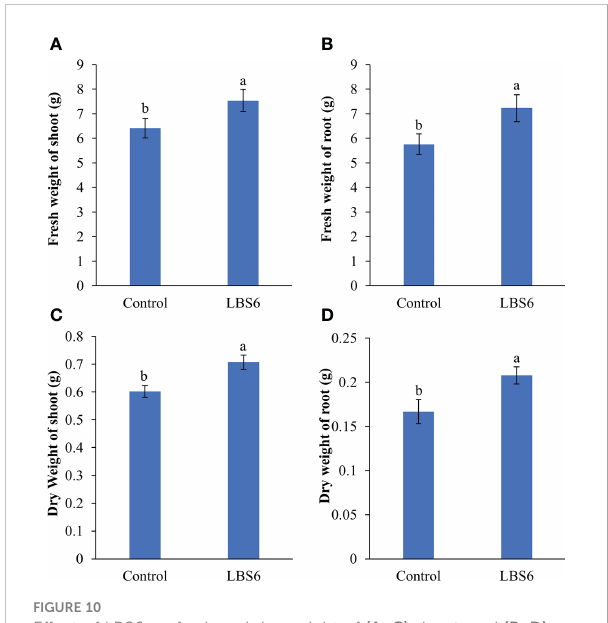
FIGURE 10 Effect of LBS6 on fresh and dry weight of (A, C) shoot, and (B, D) root, respectively. The values were presented as mean ± SE and means represented by the same letters were not signi fi cantly different at p ≤ 0.01. Each experiment was carried out in triplicate, and each experimental unit had ten plants (n = 30).